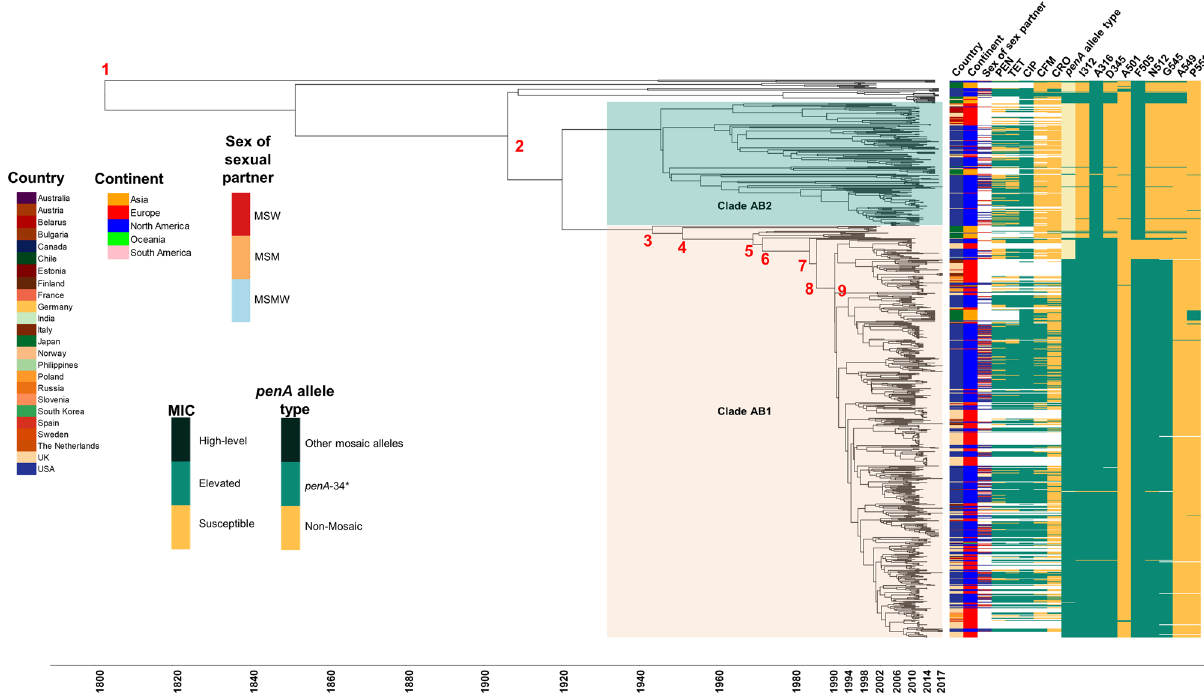
Fig. 2 Time-scaled (strict model) BEAST phylogeny of 805 isolates, including 340 GISP isolates identi fi ed in Clade A-B of this study and 465 international MLST ST1901 strains. Clade AB1 and Clade AB2 represent the divergent sub-lineages that we identi fi ed in the phylogeny. The oldest sequenced isolate is from the Philippines collected in 1992. The phylogeny includes epidemiological details and antimicrobial susceptibility. Sex of sex partners are colored [MSW men that have sex with women (red), MSM men that have sex with men (light orange), MSMW men that have sex with men and women (light blue)]. Antimicrobial susceptibility is based on minimum inhibitory concentration (MIC) to each respective antibiotic and is shown with colors: susceptible (light orange), elevated MIC range (teal), or high-level MICs (dark green). Alleles for penA are colored based on their amino acid sequence homology to penA -34 ( ≥ 98% is a derivative allele; teal), differing mosaic penA allele (dark green), or absence of a mosaic penA allele. Amino acid mutations in PBP2 associated with elevated cephalosporin MICs are shown at the top of fi gure. The bottom scale bar represents the time to the most recent common ancestor (tMRCA) of the internal node of the phylogenetic tree. Numbers highlighted in red are the ancestral nodes of the time-scaled phylogenetic tree and represent estimated years and credibility intervals based on tMRCA: 1) Root; 1818 [1781 - 1865], 2) 1925 [1913 - 1951], 3) 1944 [1935 - 1953], 4) 1952 [1942 - 1964], 5)